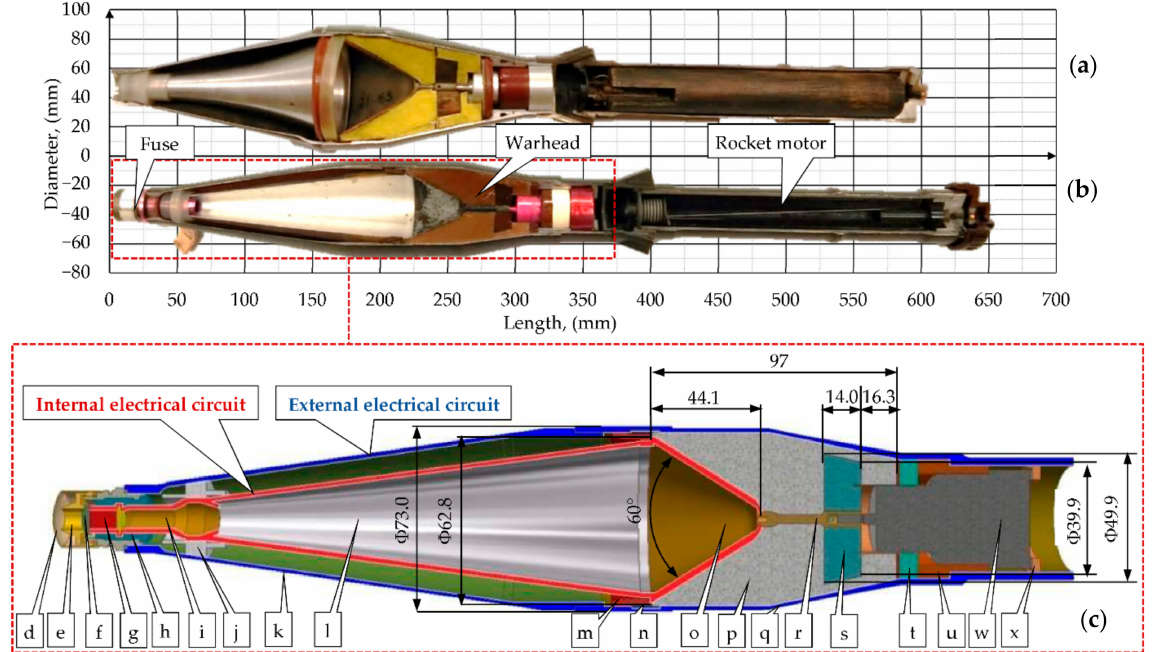
Figure 3. Comparison of the PG-7 warheads: ( a ) standard PG-7V and ( b ) modernized PG-7VM. ( c ) The cross-section and dimensions of the main components of the PG-7VM warhead: ( d ) fuse cover; ( e ) nut; ( f ) joint; ( g ) piezoelectric element; ( h ) isolator; ( i ) fuse body; ( j ) isolator sleeve; ( k ) ballistic cap; ( l ) conductive cone; ( m ) lock ring; ( n ) isolator ring; ( o ) liner; ( p ) explosive; ( q ) warhead body; ( r ) conductor; ( s ) cover; ( t ) isolator; ( u ) sleeve; ( w ) bottom part of the fuse; ( x ) lock